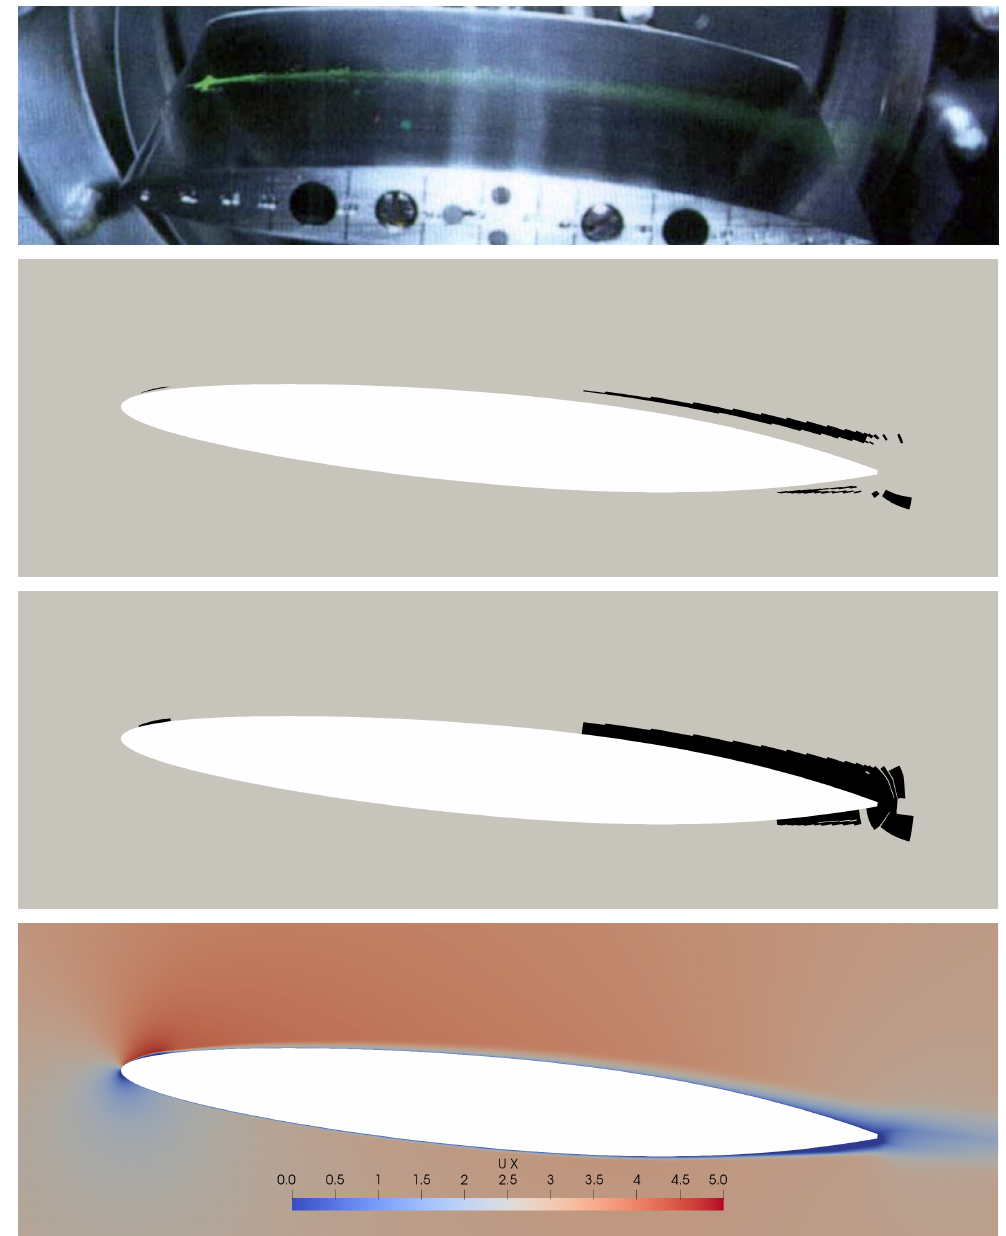
Figure 6. Visualization of laminar transition for NACA16012, AoA = 5 ◦ , Re = 300,000. From top to bottom: experimental photograph; predicted SepInd org ; predicted SepInd ; predicted velocity in flow